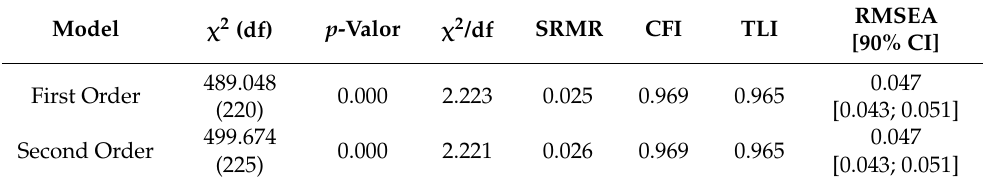
Table 3. Goodness-of-fit indices obtained in the CFA.